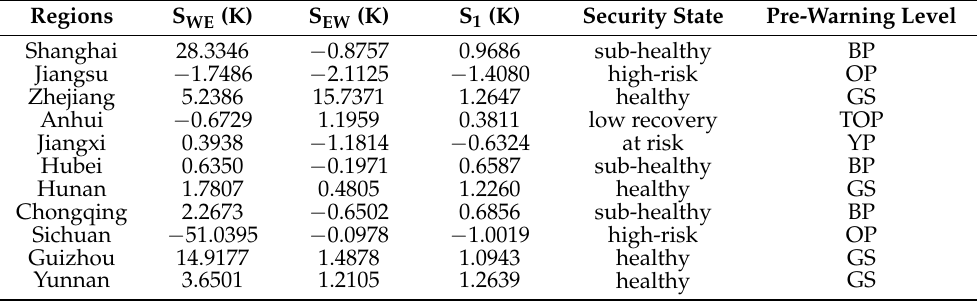
Table 3. Results of symbiotic security index from the perspective of water-energy symbiosis.